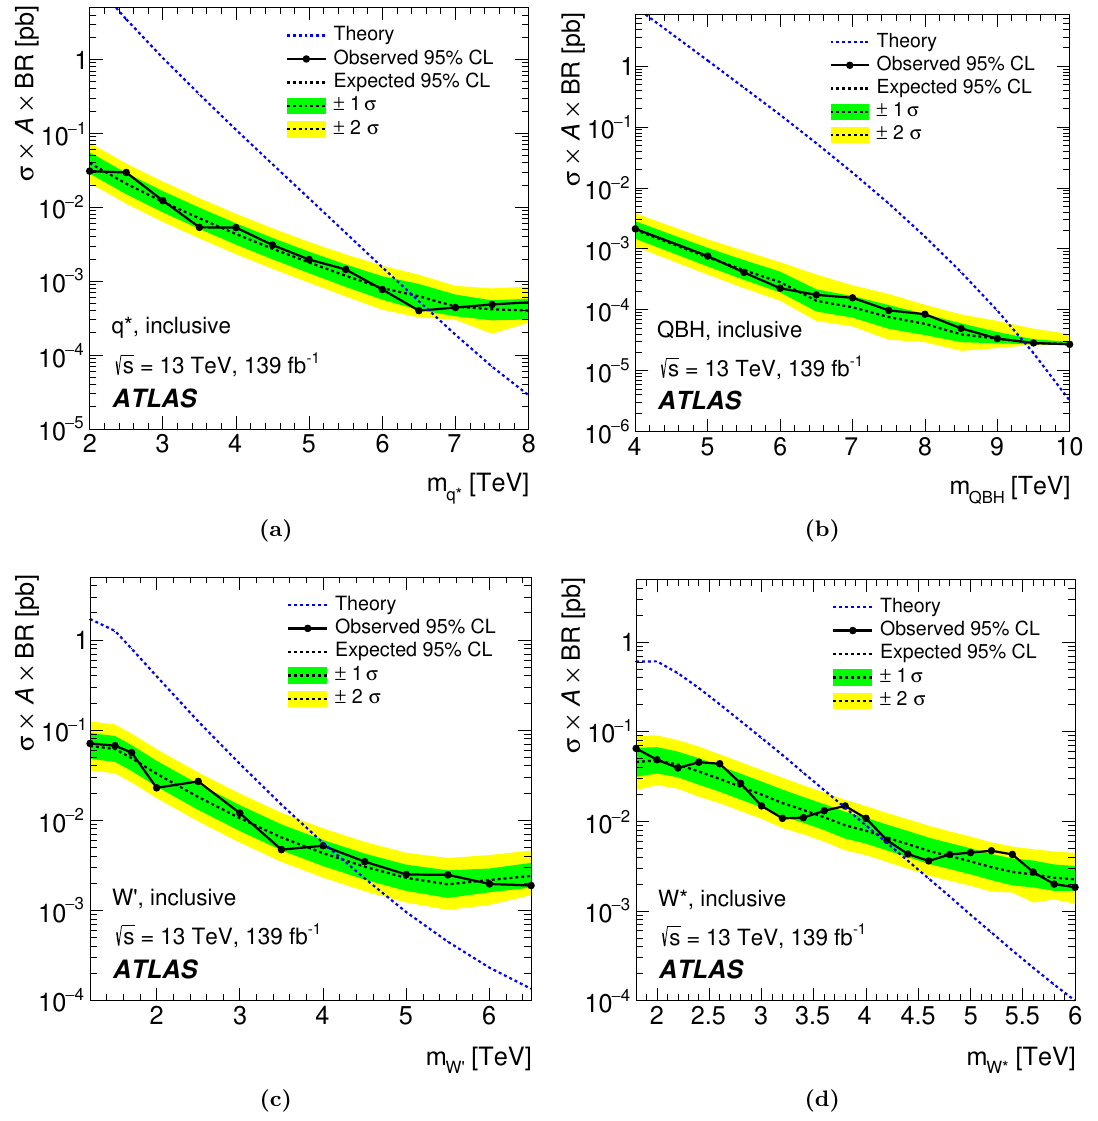
Figure 4 . The 95% CL upper limits on the cross-section times acceptance times branching ratio into two jets as a function of the mass of (a) q (cid:3) , (b) QBH, (c) W 0 and (d) W (cid:3) signals. The expected upper limit and corresponding (cid:6) 1 (cid:27) and (cid:6) 2 (cid:27) uncertainty bands are also shown. These exclusion upper limits are obtained using the inclusive dijet selection, with the selection described in the text and summarised in table